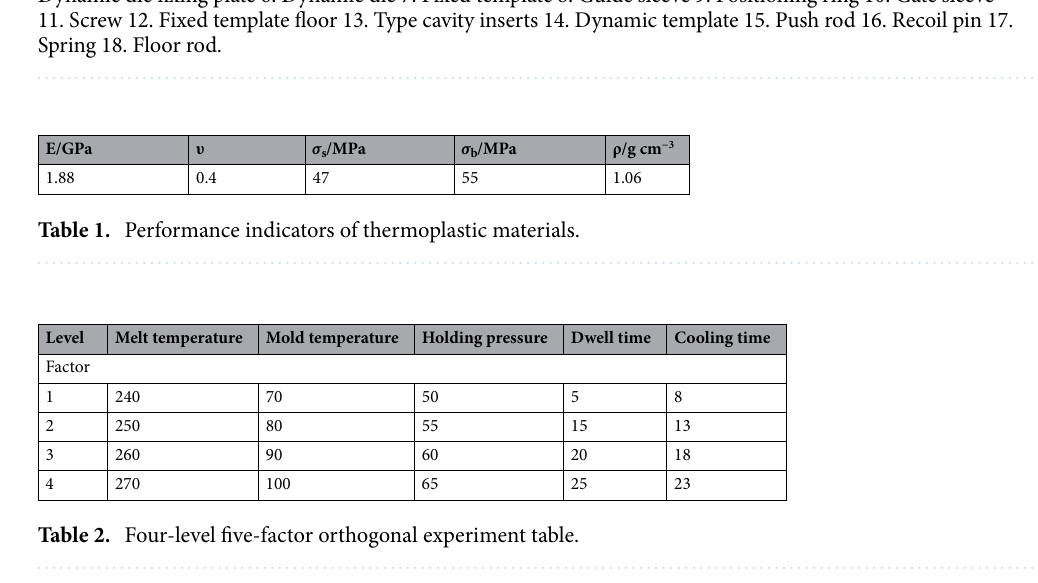
Figure 3. Cylinder liner mold assembly drawing. 1. Floor 2. Push rod fixing plate 3. Push rod 4. Push rod 5. Dynamic die fixing plate 6. Dynamic die 7. Fixed template 8. Guide sleeve 9. Positioning ring 10. Gate sleeve